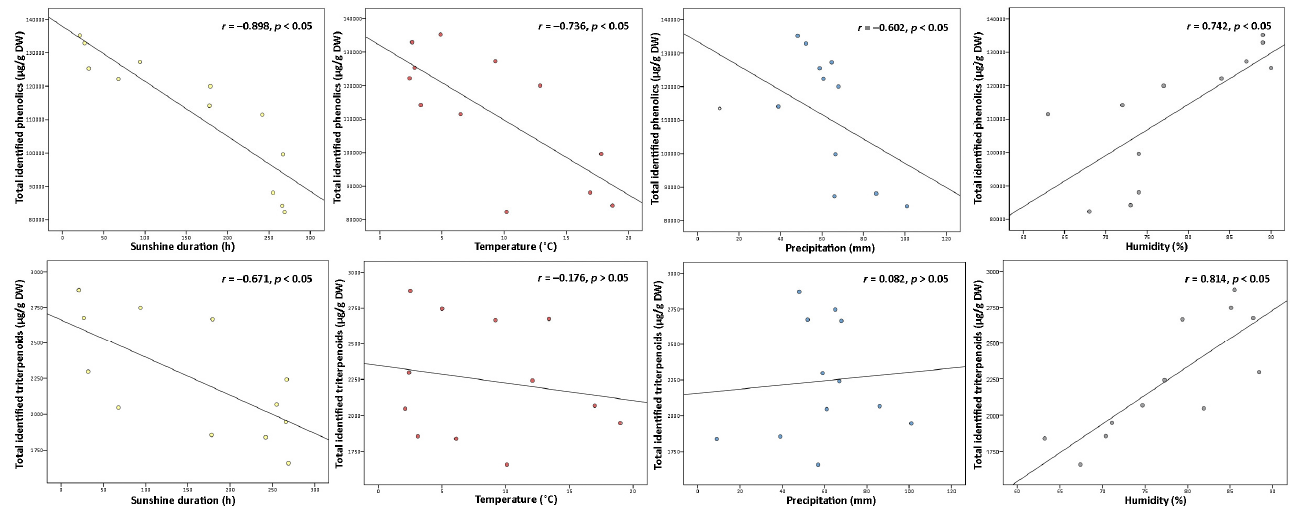
Figure 4. Correlations between sunshine duration (h), temperature ( ◦ C), precipitation (mm), and humidity (%) throughout the year with total identified phenolic and triterpenoid contents ( μ g/g DW) in lingonberry leaves.